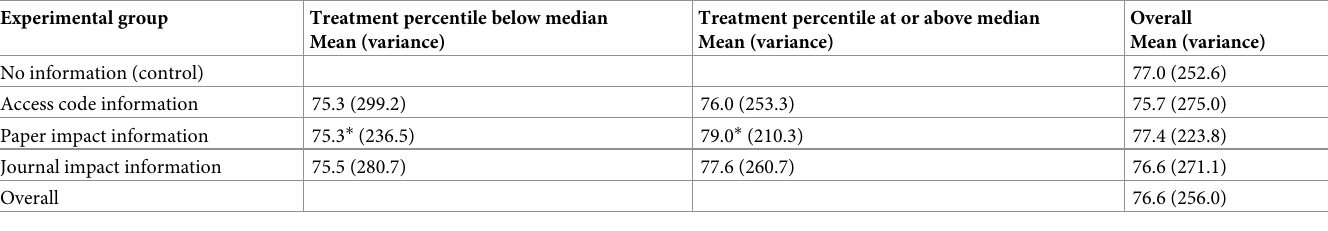
Table 4. Quality assessments of articles with treatment percentiles below and at/above the median. Experimental group Treatment percentile below median Treatment percentile at or above median Mean (variance) Mean